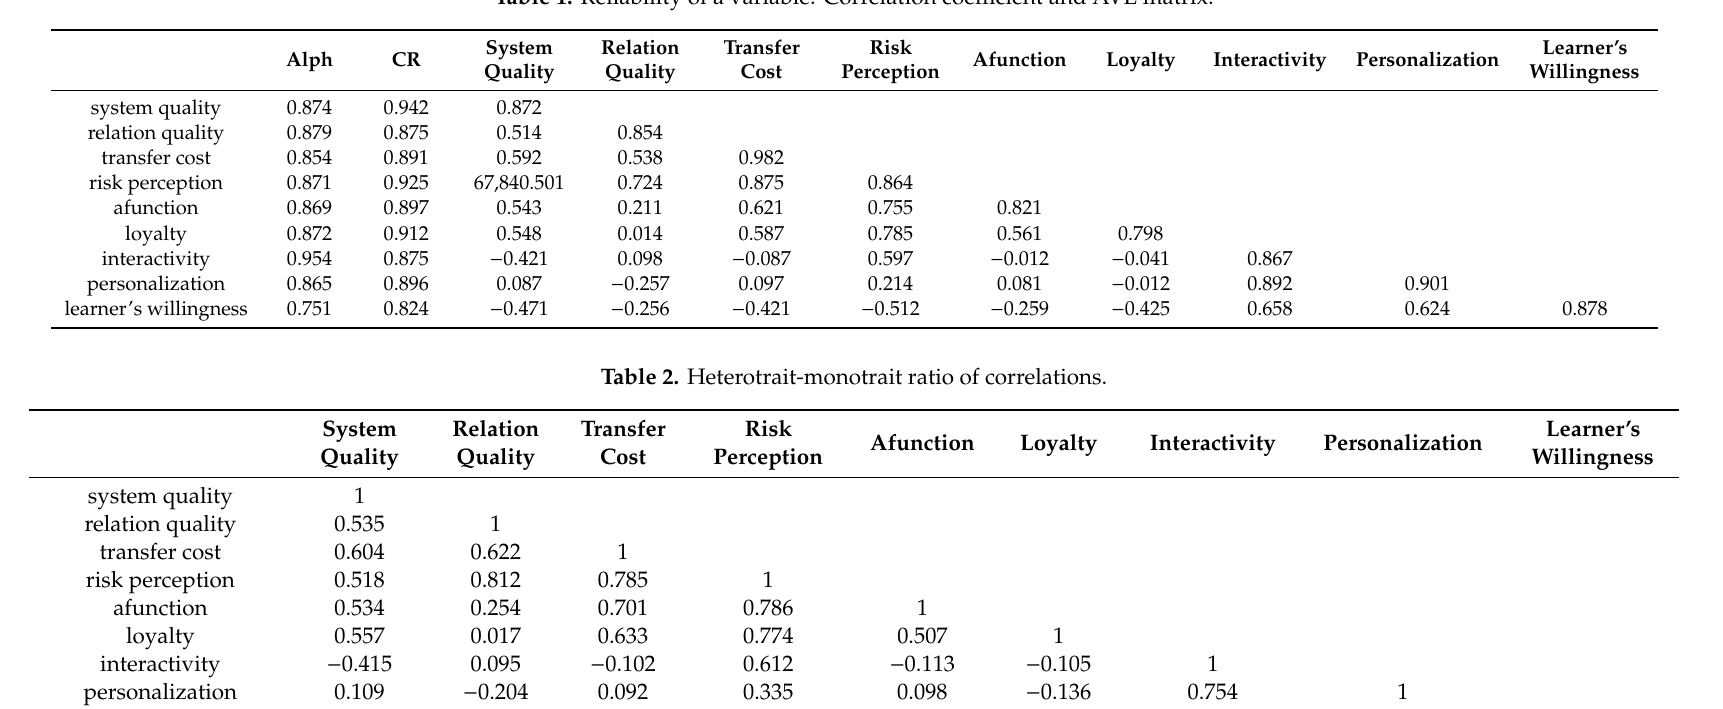
Table 1. Reliability of a variable. Correlation coe ffi cient and AVE matrix.